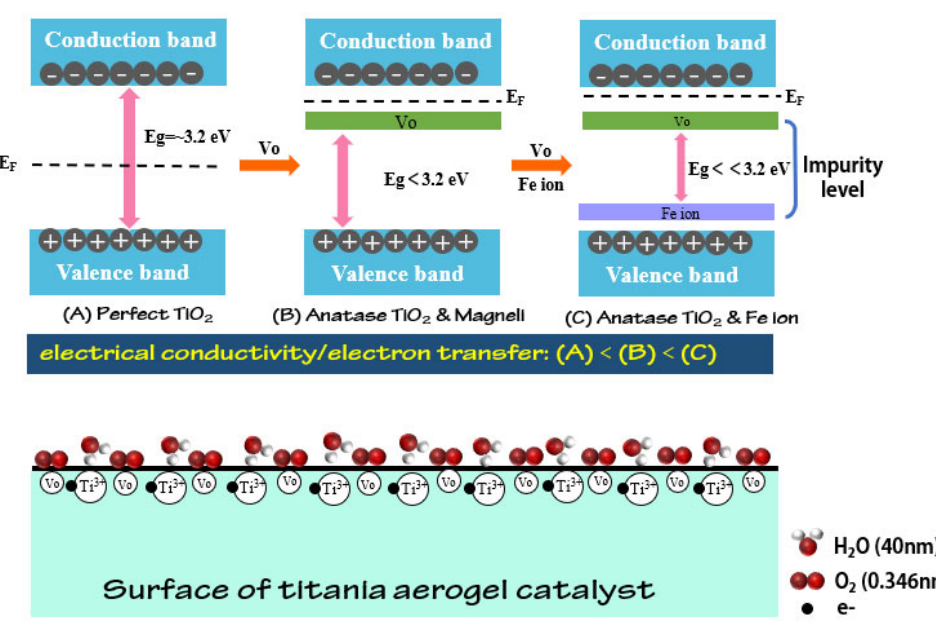
Figure 13. The influence mechanism of the oxygen vacancies, doping effect, and pore structure.